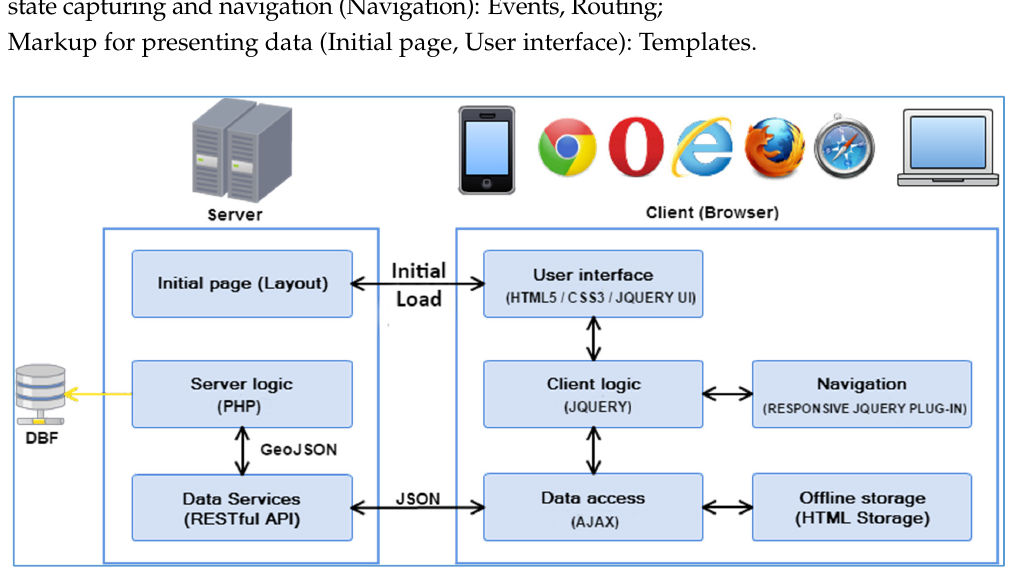
Figure 11. The Single-Page Application (SPA) Architecture.